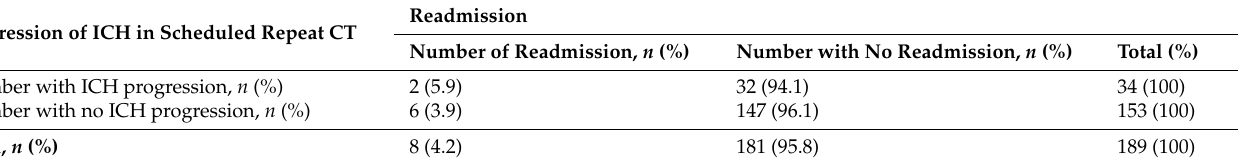
Table 6. Progression of ICH in scheduled repeat CT brain in relation to readmission of the